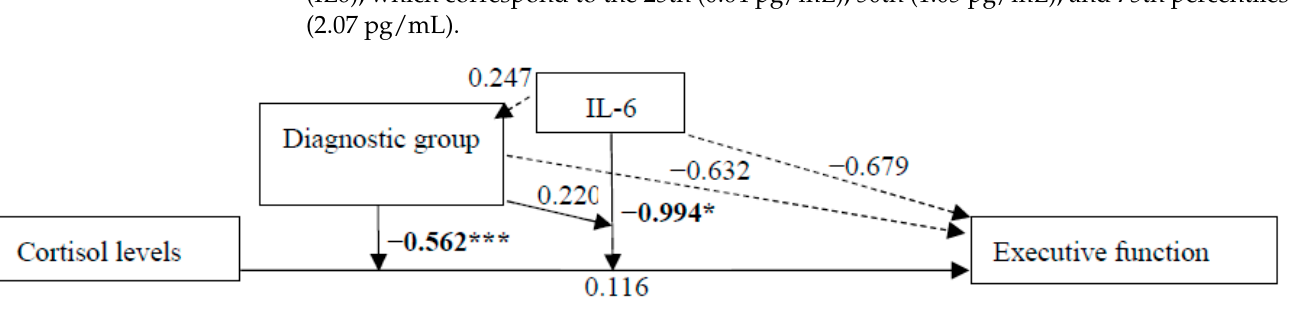
Figure 2. Unstandardized regression coefficients for the relationship between cortisol levels and executive function with moderator IL-6 in the total sample. Sex, waist circumference, depression diagnosis, and performance in a receptive vocabulary task, as a measure of educational level, were included as confounders in all models. * p ≤ 0.05.